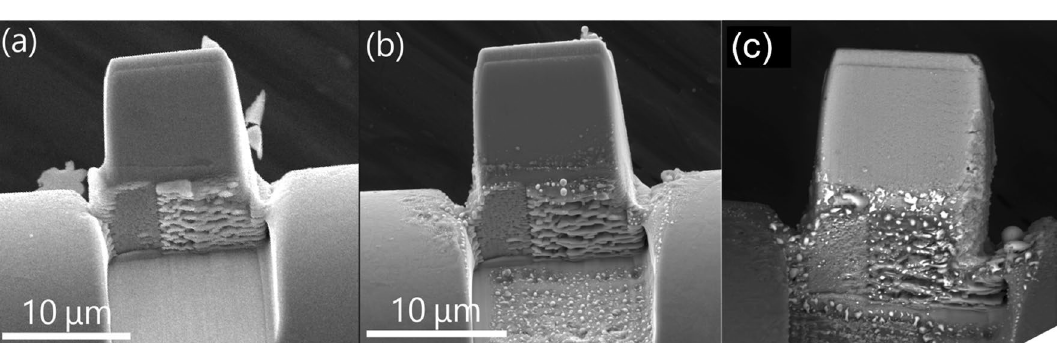
Figure 3. Electron micrographs of one of the sample cubes as received ( a ), after U, Pu, and Am isotopic analysis ( b ), and after further analysis for Mo, Ru, and Sr isotopic composition ( c